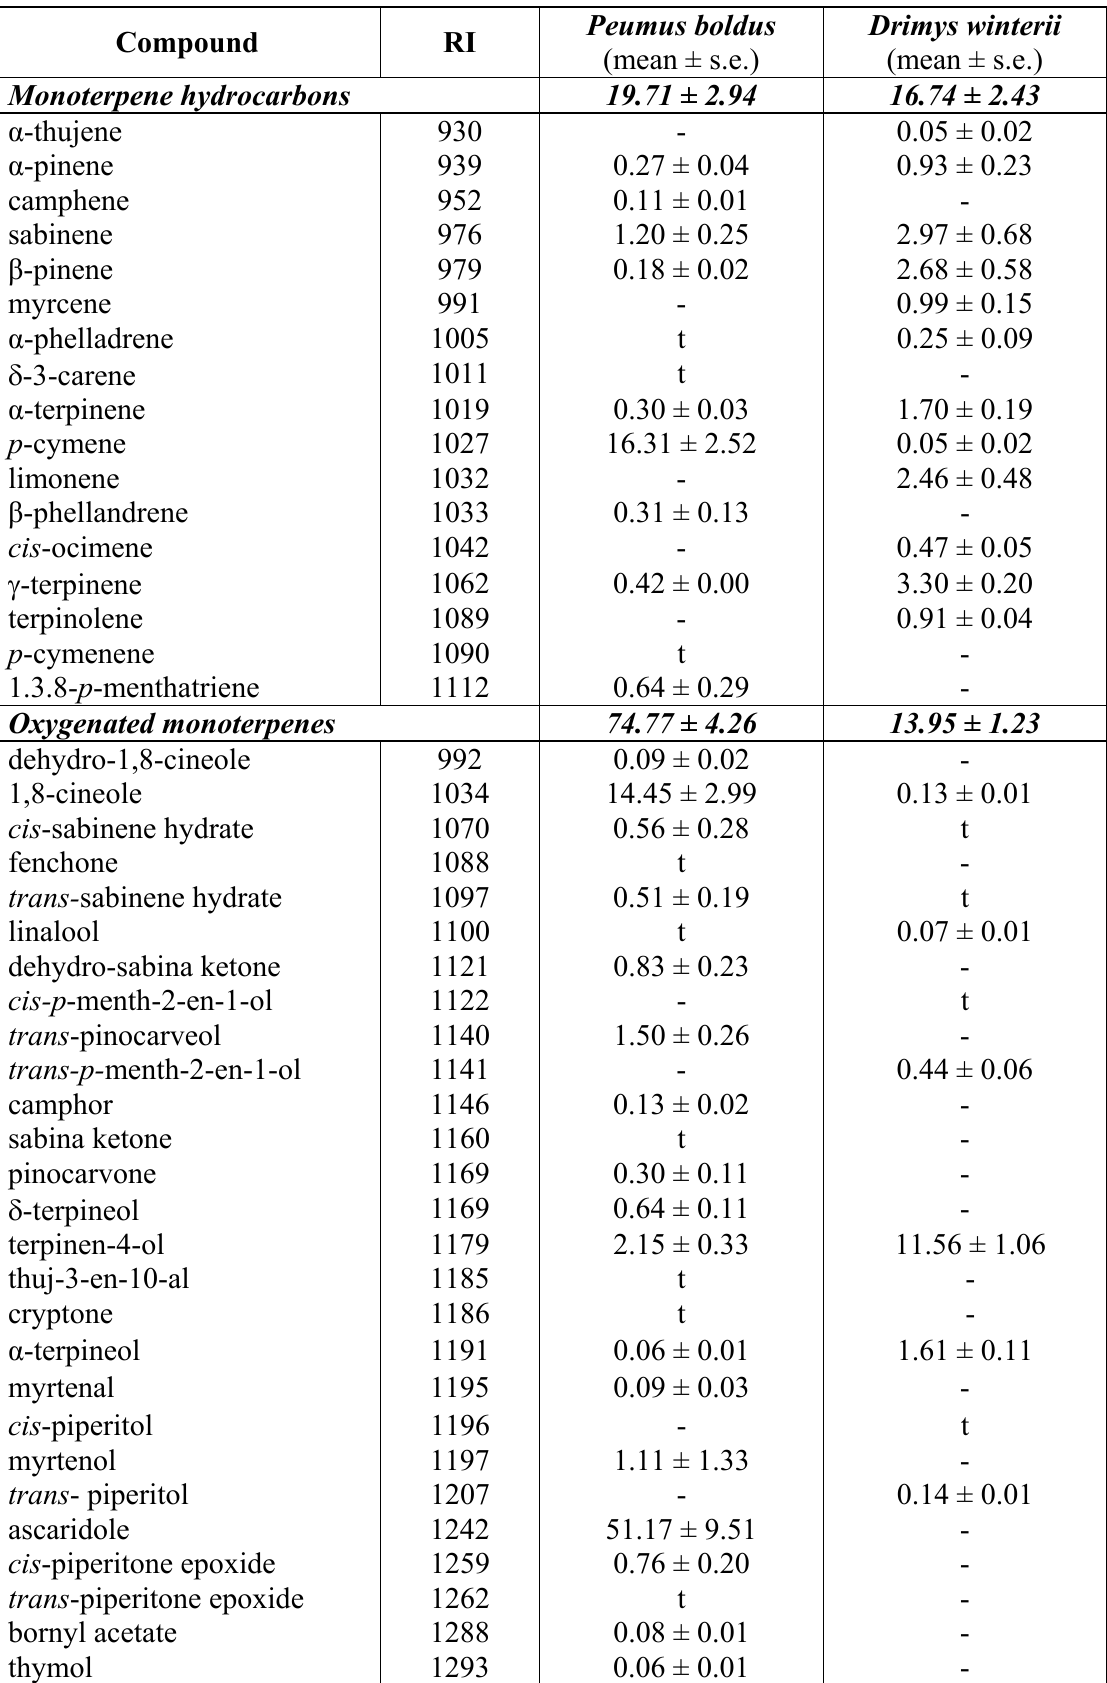
Table 1. Constituents of the essential oils from Peumus boldus , and Drimys winterii by GC and GC-MS